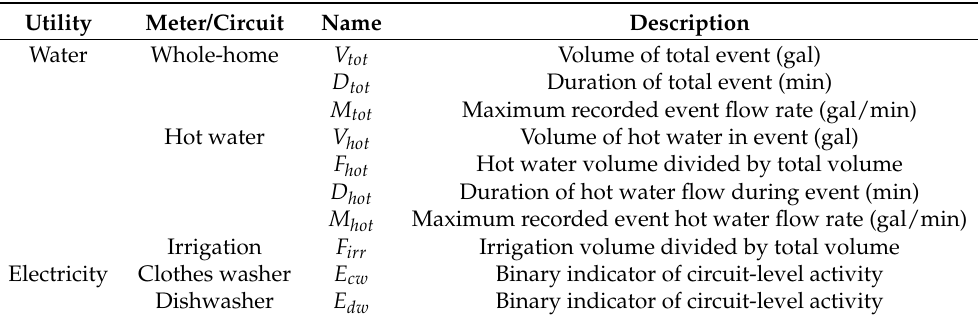
Table 1. A summary of the 10 input features defined for each event in the merged REU2016 dataset. Combinations of these features were used for classifier